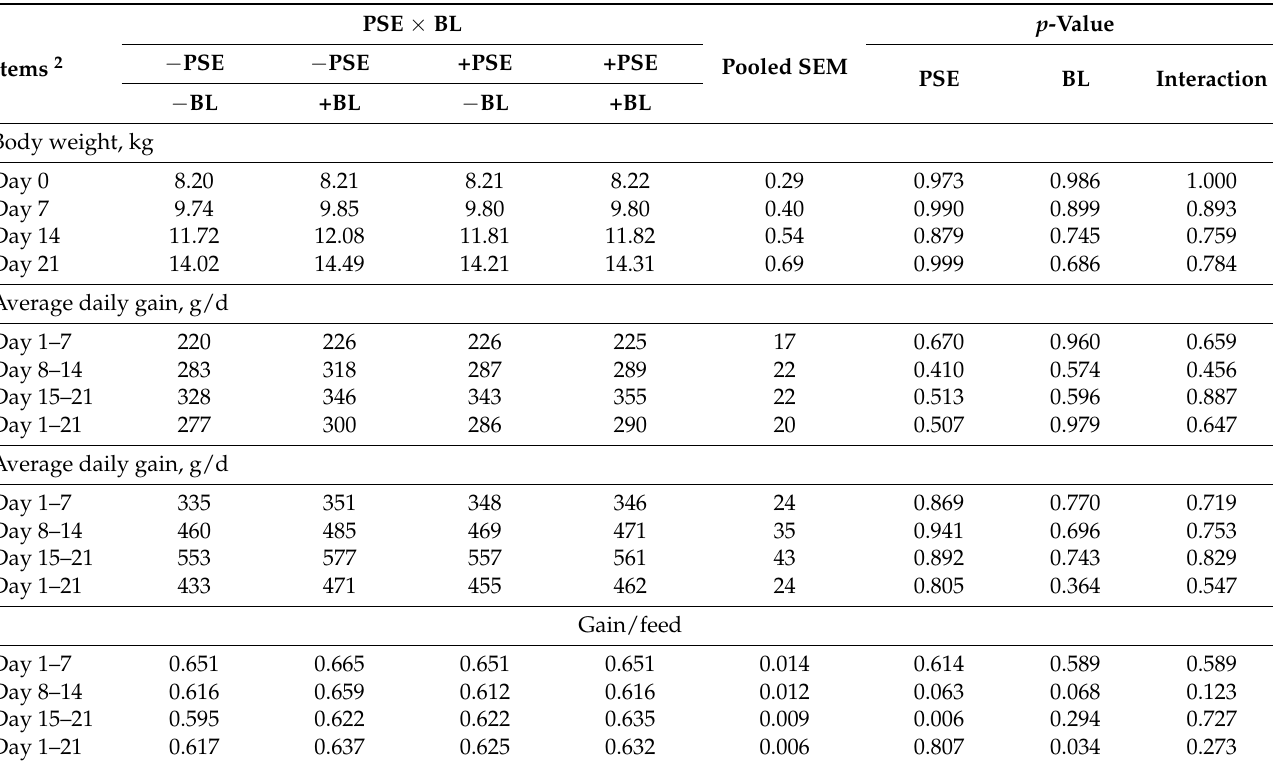
Table 2. Effects of BL and PSE supplementation on growth performance of weaned piglets 1 .